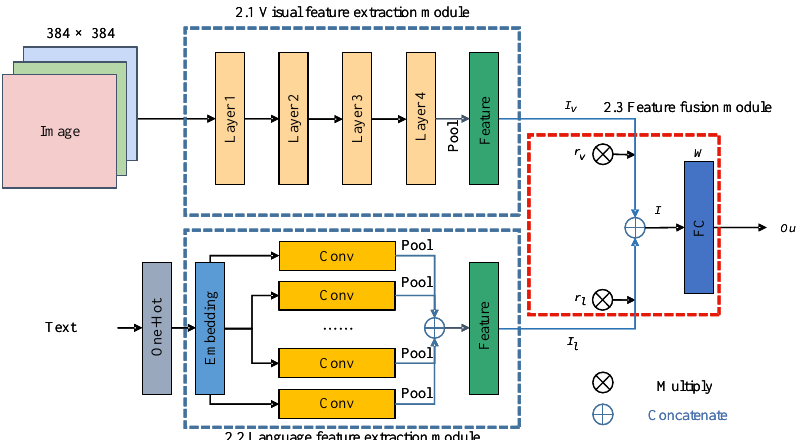
Figure 1. Structure of Enhanced Framework for Multimodal Feature Complementarity Based on the Modal Feature Random Deactivation Training